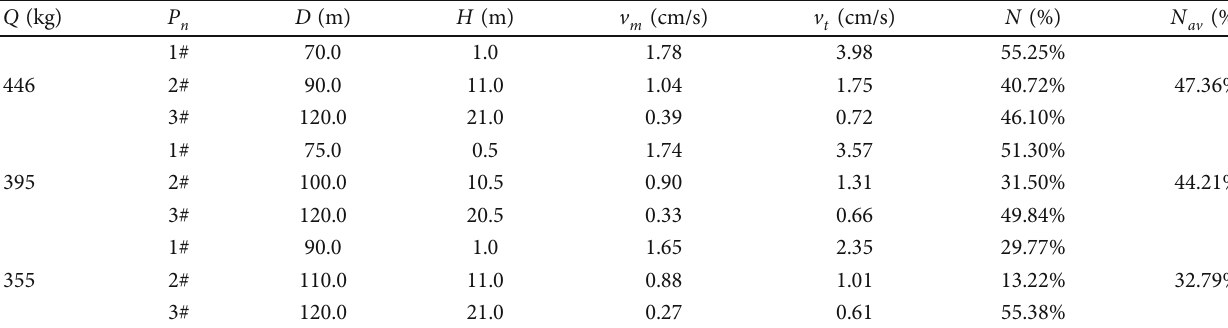
Table 6: Comparative analysis of blasting vibration by presplit holes detonated